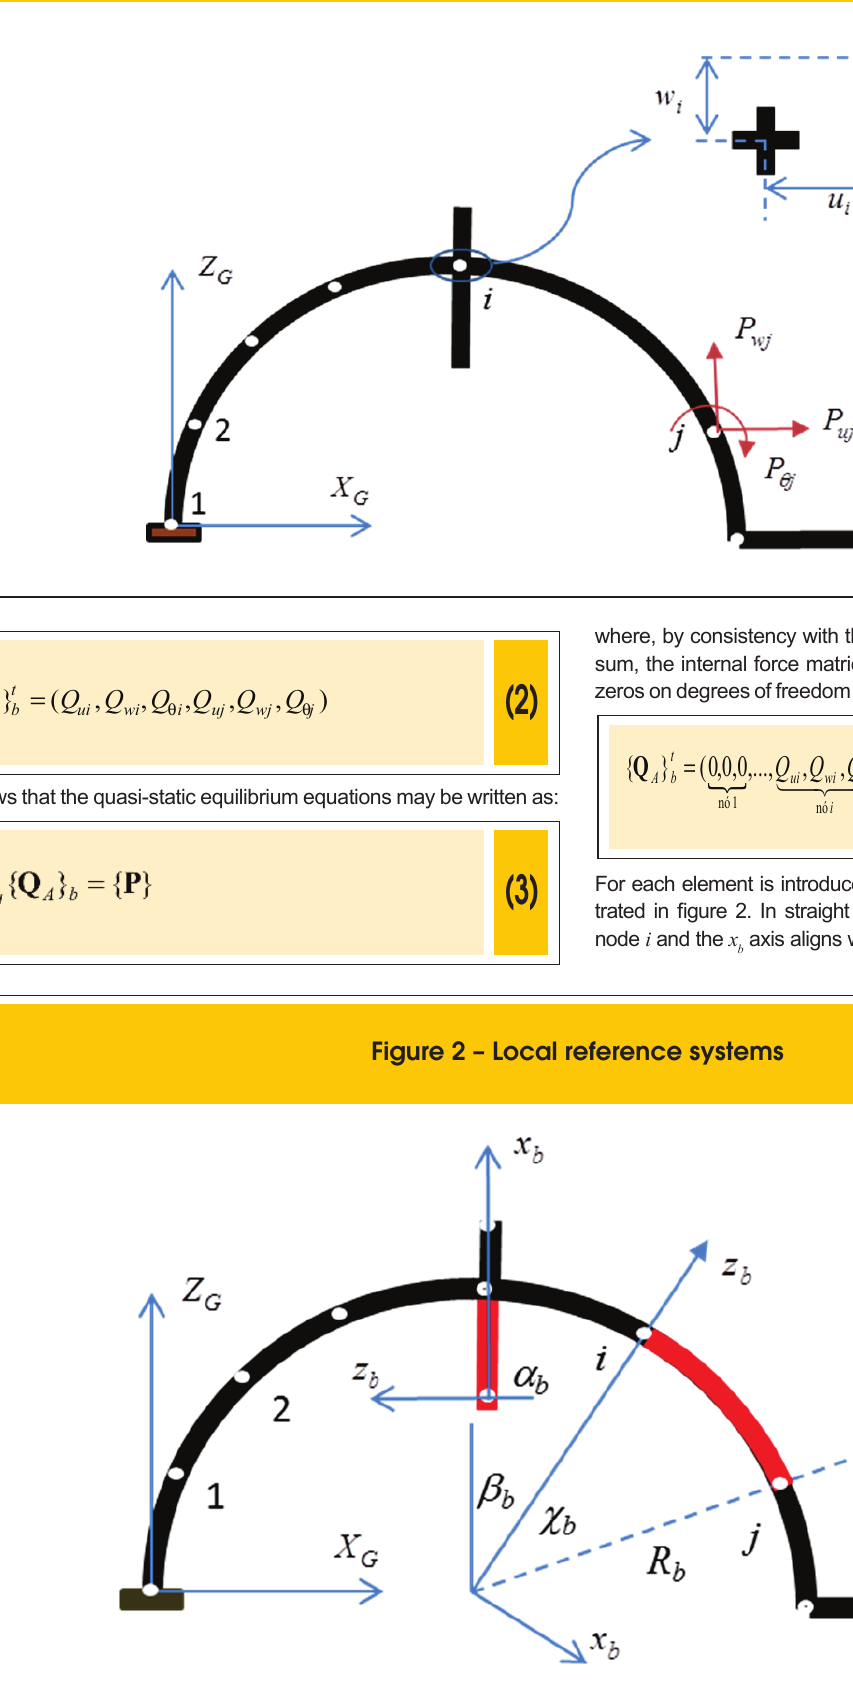
Figure 1 – External forces and generalised displacements according to the global reference system